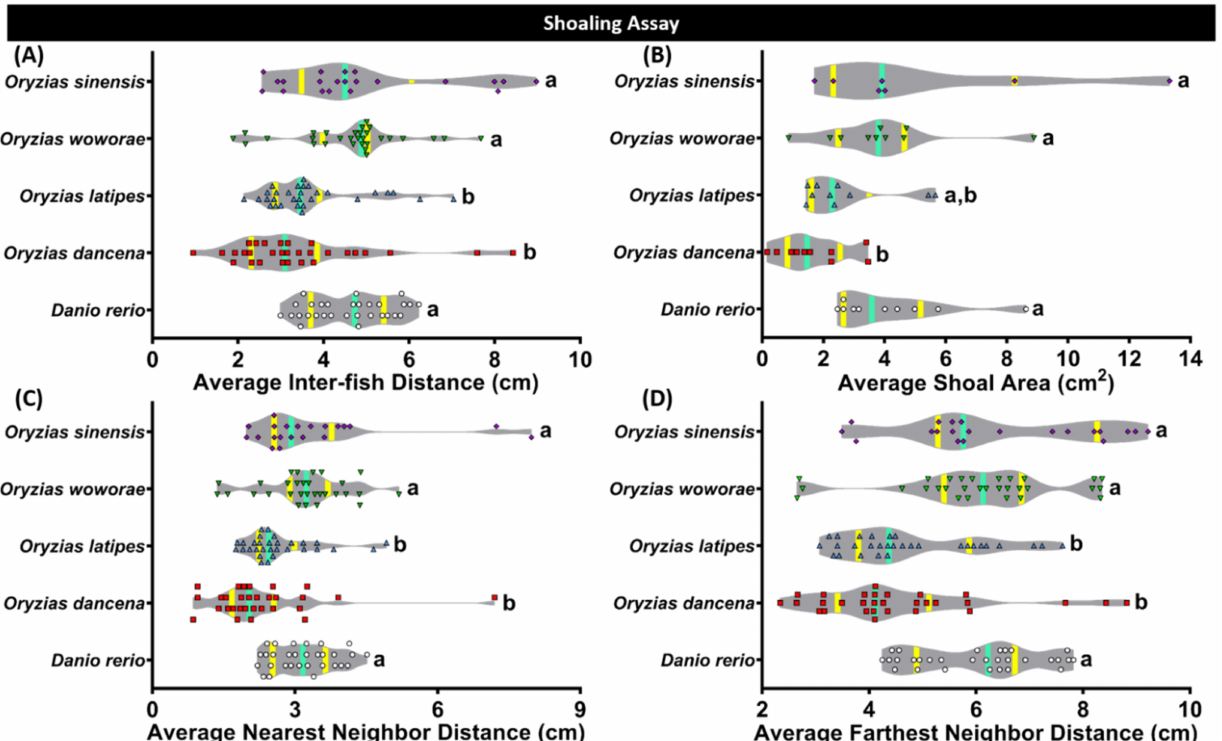
Figure 4. Shoaling behavior comparisons between each tested fish species (medaka and zebrafish). ( A ) Average inter-fish distance, ( B ) average shoal area, ( C ) average nearest neighbor distance, and ( D ) average farthest neighbor distance were analyzed. Groups of three fish were tested for shoaling behavior. The data were analyzed by the Kruskal–Wallis test continued with uncorrected Dunn’s test. Different letters (a, b) on the error bars represent a significant statistical difference ( p < 0.05) ( n = 30 for zebrafish, O. dancena , O. latipes , and O. woworae ; n = 21 for O. sinensis ). The median and interquartile for the violin plot were labeled with the bold line colored with cyan and